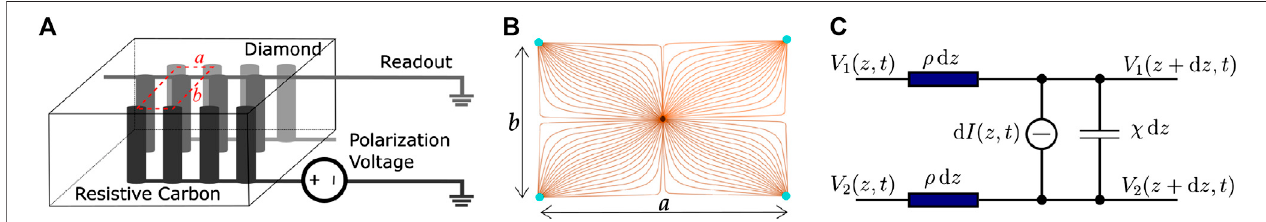
FIGURE1 |(A) schematicrepresentationofthegeneric3D a × b rectangularelementarycell(nottoscale). (B) projectionofthecellonthetransverseplane,withblackand cyan circles representing the electrodes connected by electric fi eld fl ux lines in brown. (C) electrical model of a single cell used to describe the charge relaxation. The voltage differencebetween V 1 and V 2 encodesthesignalgeneratedbyanin fi nitesimalcurrentd I aspropagatedthroughanelectrodepair.Theelectricalparametersofthetransmission linesarethedistributedresistivity ρ andcapacitance χ .Together,thetwomodelsfortheelectric fi